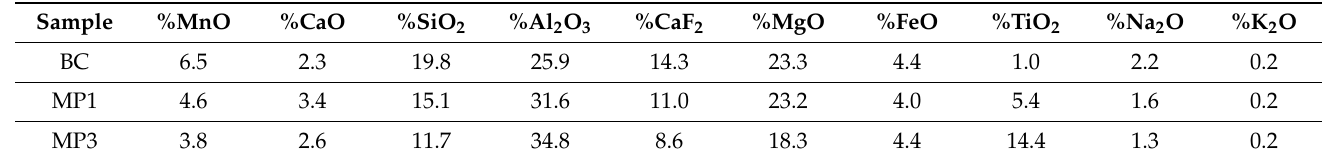
Table 3. Bulk chemical compositions of post-weld slags (mass%).